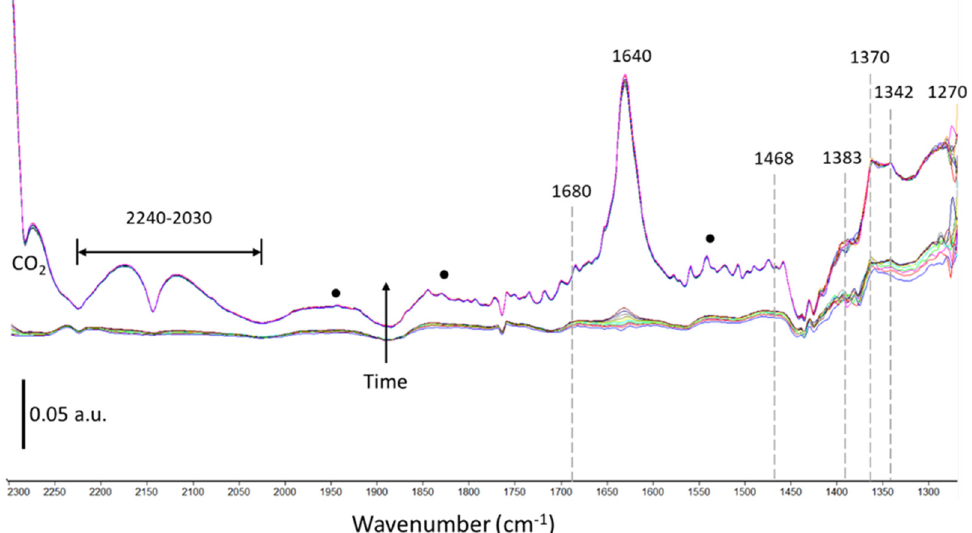
Figure 9. FTIR subtraction spectra acquired as a function of time up to steady state after plasma ignition in CO 2 methanation conditions on CsUSY, in the 2400–1250 cm − 1 region. (Black dots indicate bands assigned to USY zeolite”.)